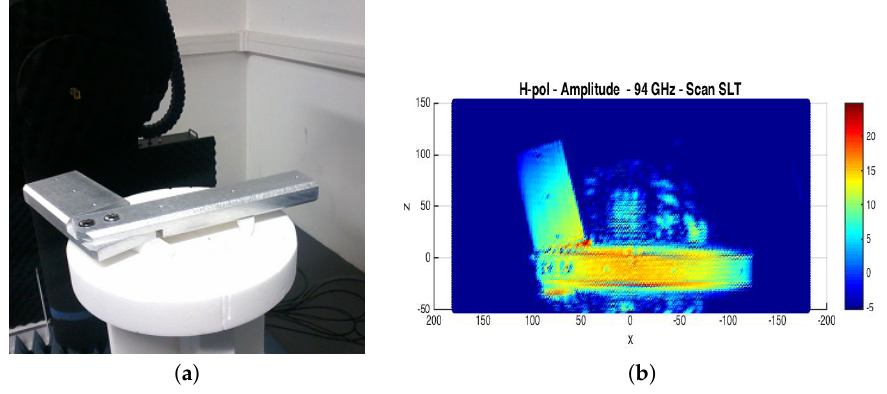
Figure 3. ( a ) Fake gun; ( b ) radar acquisition.